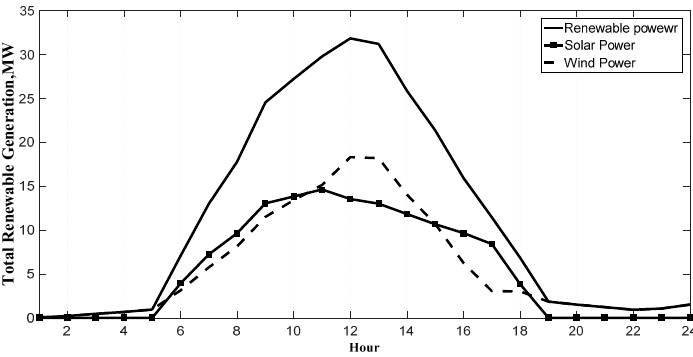
Figure 4. Solar, wind and total renewable power generation.